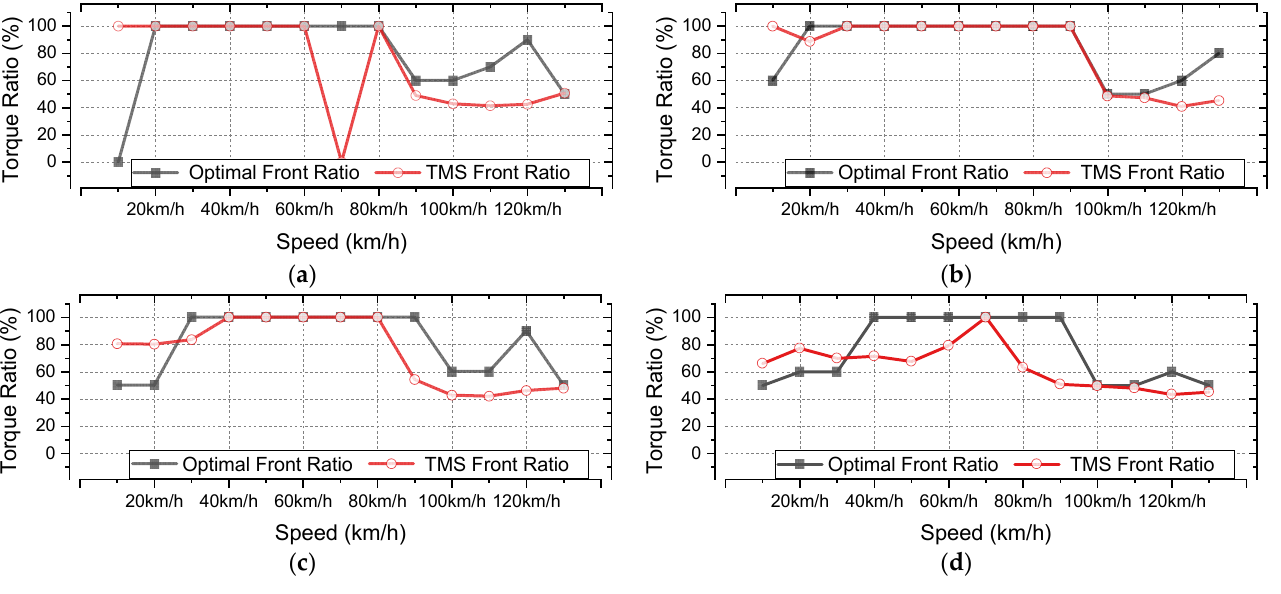
Figure 8. Torque Distribution ratio of optimal 4WD and TMS: ( a ) Gear ratio 10:1, ( b ) Gear ratio 8:1, ( c ) Gear ratio 7:1 ( d ) Gear ratio 6:1.